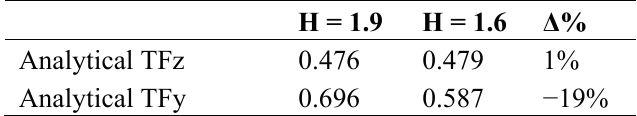
Table 2. Evolution of the analytical transmission factors (tf z , tf y ) values of the tractor employed in the real test when the height of the tractor seat is reduced by 15%, from 1.9 to 1.6